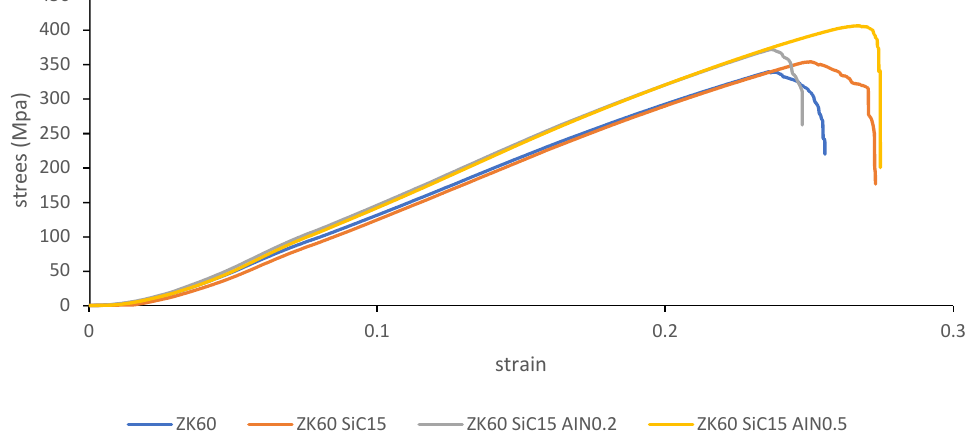
Figure 10. Compression test result of the unreinforced ZK60, ZK60 SiC15, ZK60 SiC15 AlN0.2 and the ZK60 SiC15 AlN0.5.